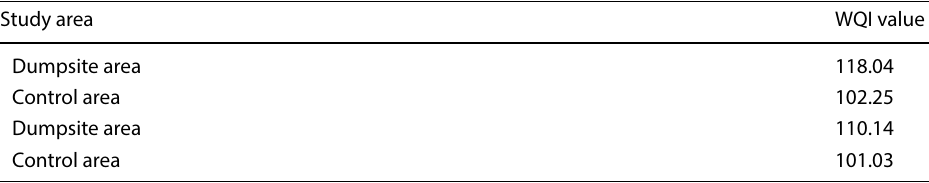
Table 4 Water quality